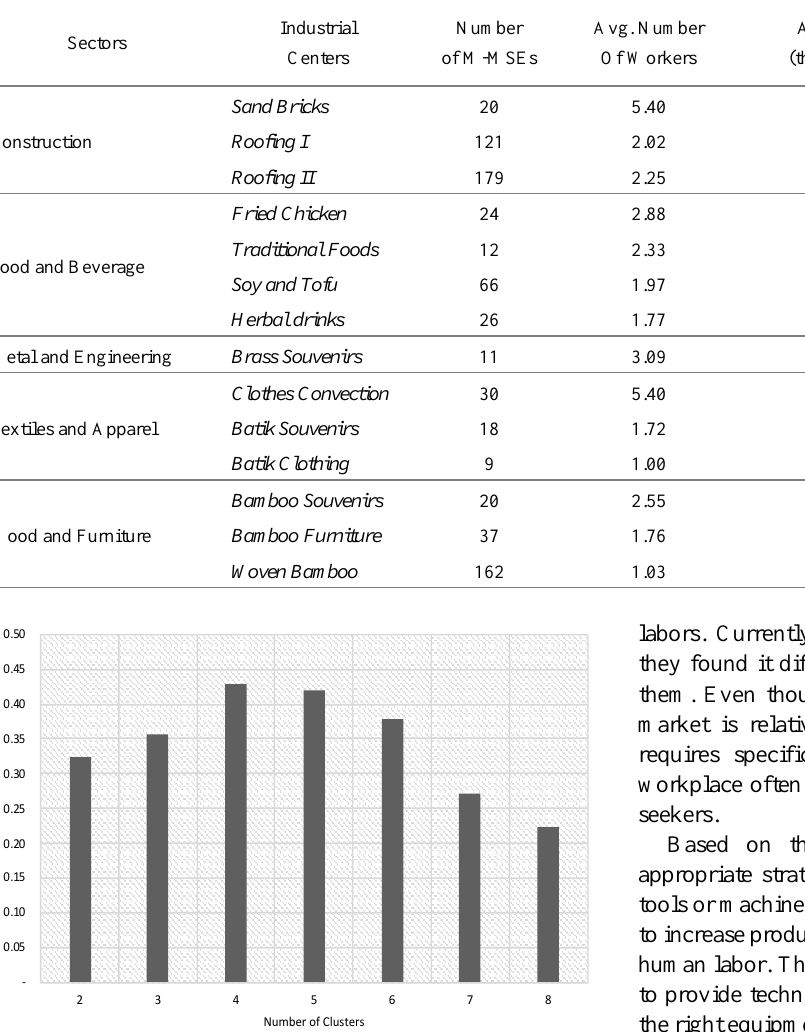
Fig. 2. Silhouette score for a various number of